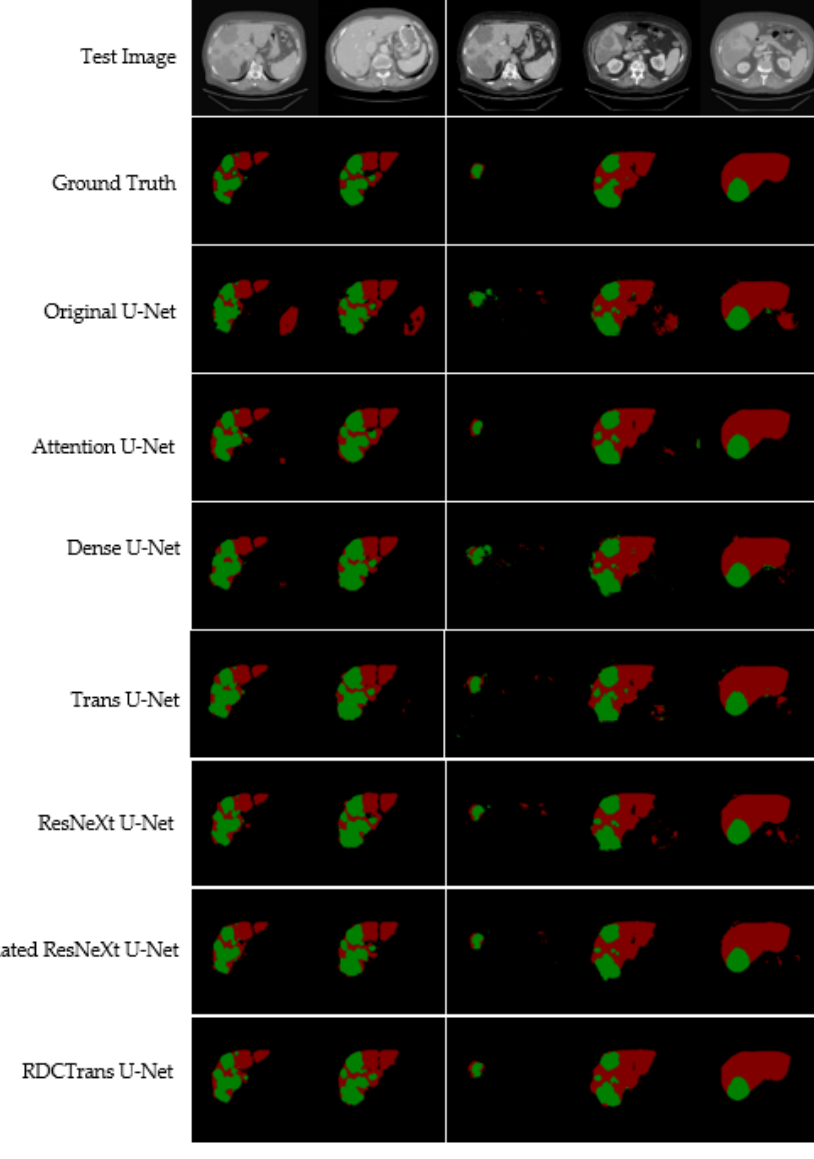
Figure 7. Illustrates the liver and tumor segmentation results of different methods on the test dataset. The red area represents the liver, and the green area represents the tumor.